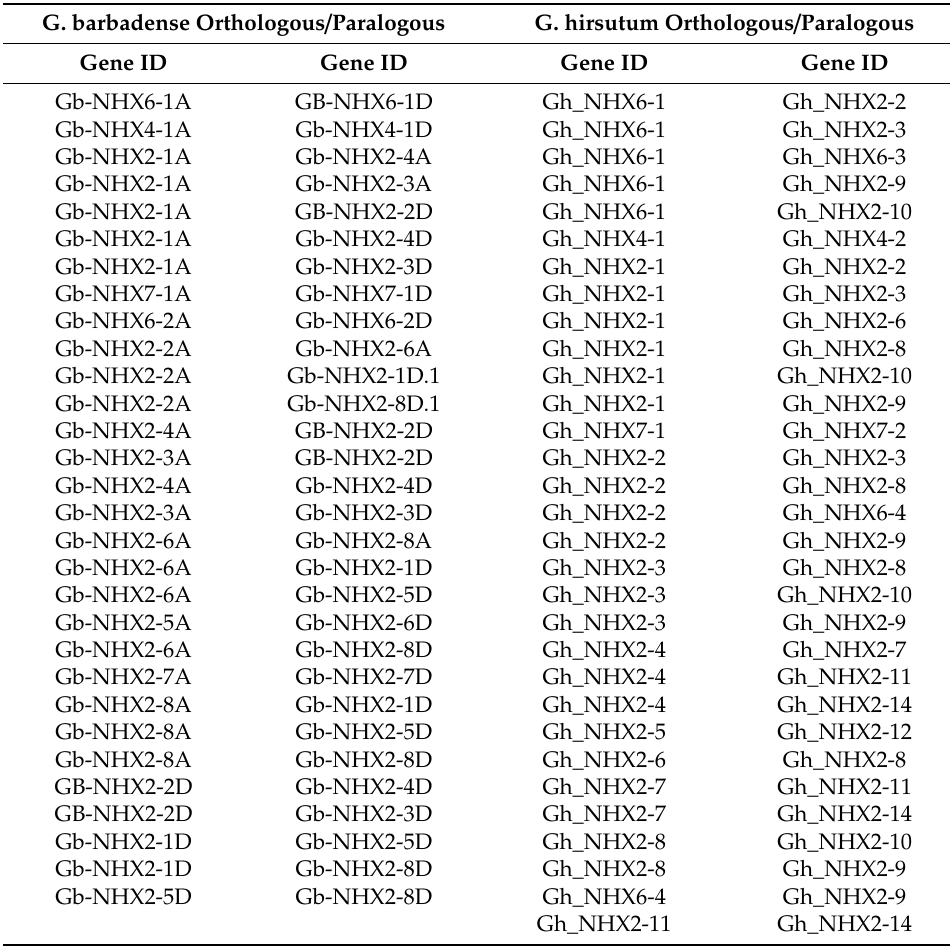
Table 3. Orthologous and paralogous gene pairs for Gb and